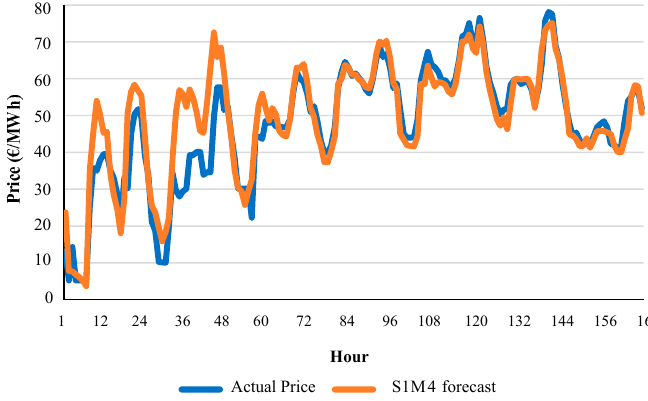
Figure 7. Actual price values and forecast values of model S1M4 of intraday session 1 for week 7 of year 2013.